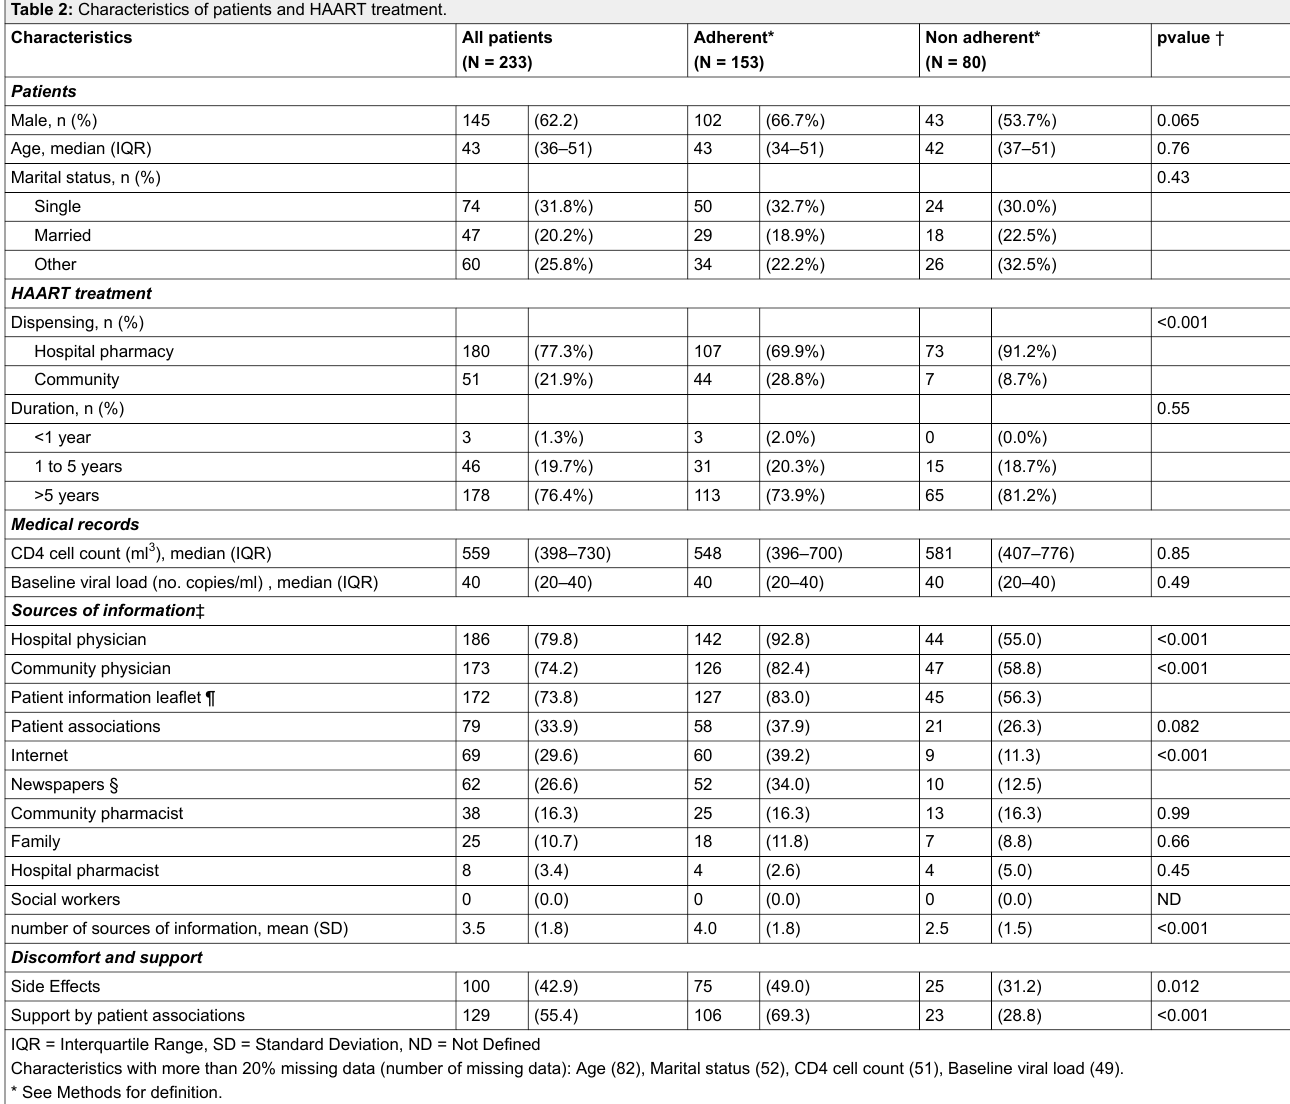
Table 2: Characteristics of patients and HAART treatment. Characteristics